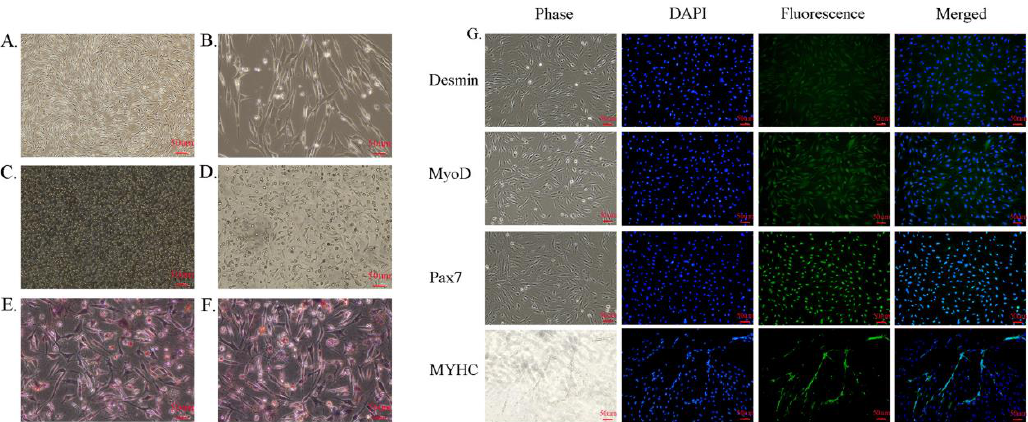
Figure 2. SCs identification results and test procedure. ( A ) SCs lipogenesis is induced for 1 d; ( B ) SCs morphology becomes flattened after lipogenesis induction. ( C , D ) SCs lipogenesis is induced for 14 d; ( E , F ) SCs lipogenesis is induced after oil red O staining, and intracellular lipid droplets are stained orange–red; ( G ) SCs immunofluorescence staining for anti-desmin, anti-MyoD, anti-Pax7, and anti-MYHC is indicated in green, and nuclei are stained blue with DAPI. Scale bar: 50 μm.